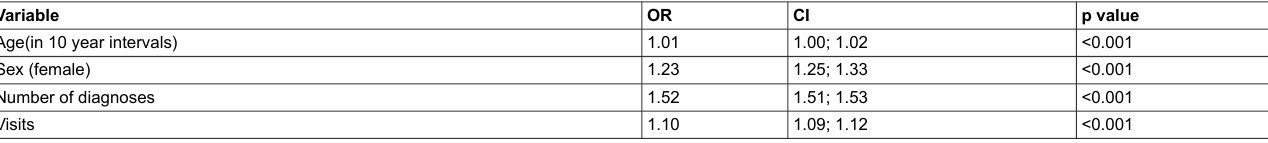
Tabel 2: Multinomial logistic regression – General Consent status: declined vs. not issued. Variable